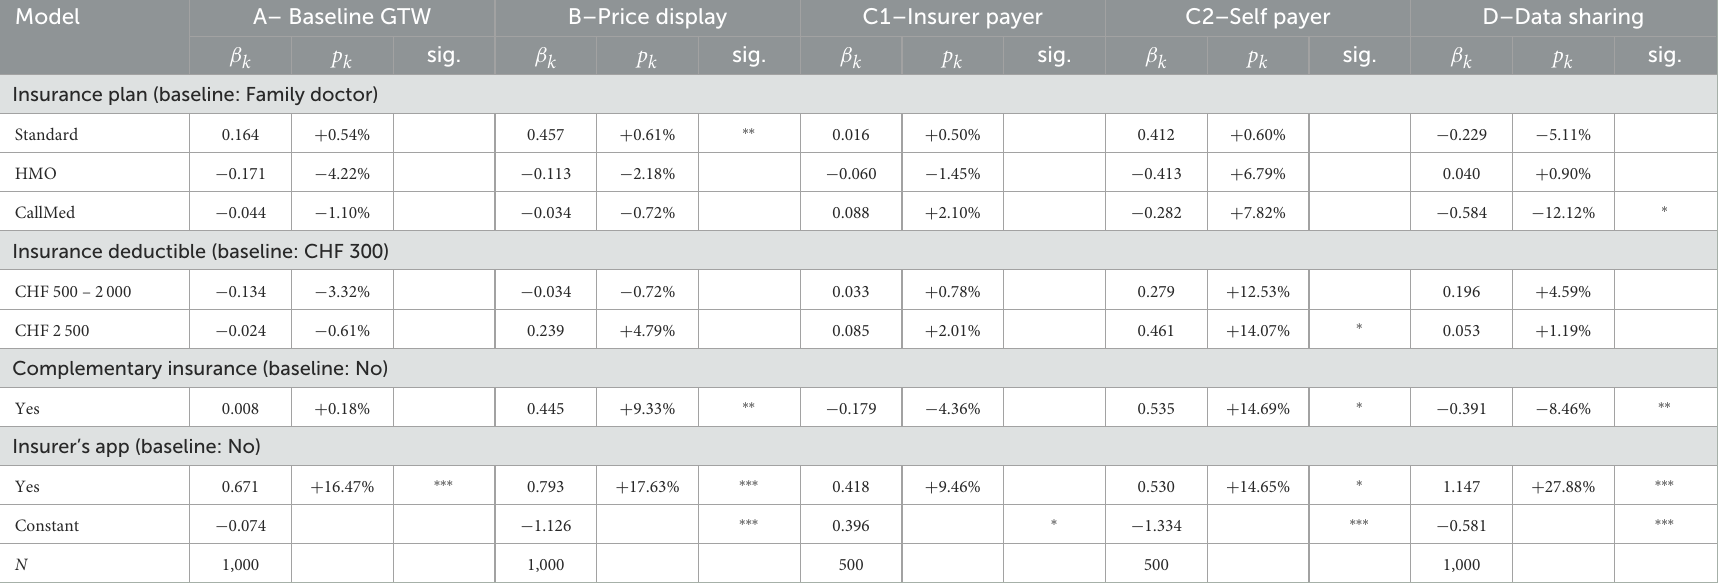
TABLE 8 Regression results for insurance factors.